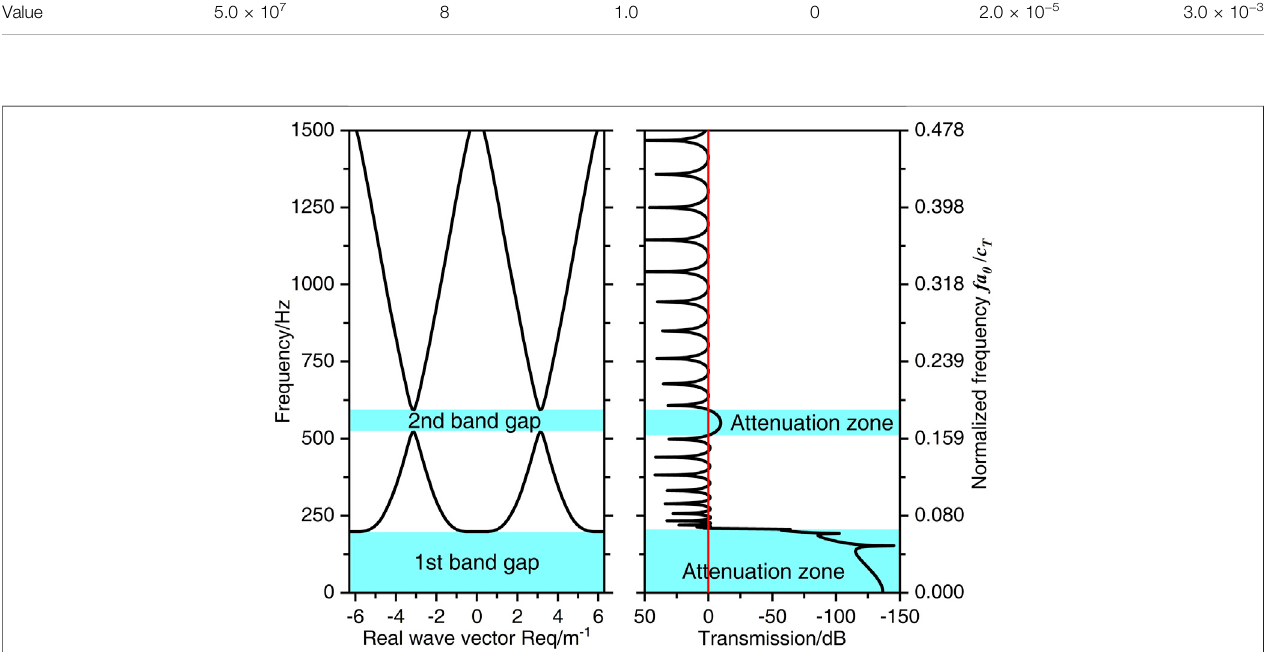
FIGURE2|(A) The fl exuralwavebandgapscharacteristicsofthein fi nitelonghomogeneousbeamcoupledwithperiodicoscillators. (B) The fl exuralwavevibration transmission spectrum of the fi nite long homogeneous beam coupled with periodic oscillators with 12 unit cells.